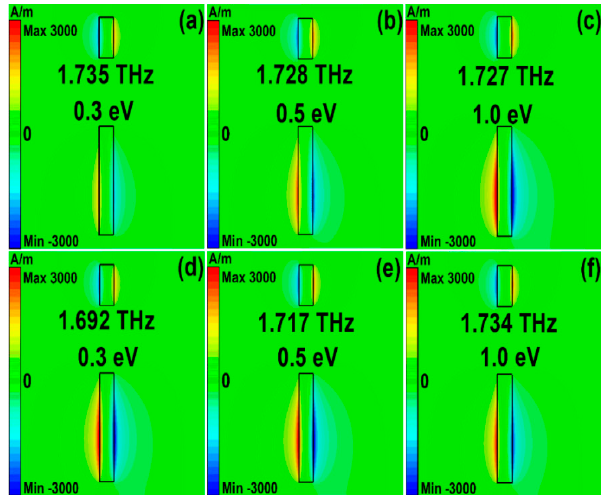
Figure 8. The magnetic fields for the asymmetrical graphene stripe patters structures at different Fermi levels. ( a–c ) The simulation results for Model I. ( d–f ) The simulation results for Model II on condition that the phonon scattering was taken into account. The polarization direction of incident light was along the y direction. The graphene Fermi levels were 0.3, 0.5, and 1.0 eV, respectively.